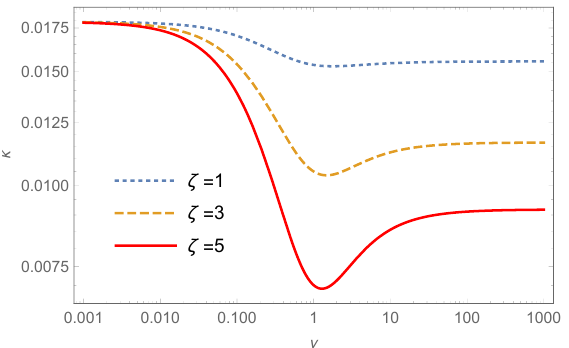
Figure 9 . The dependence of the transition rate of the Hawking-Page phase transition from the large SAdS black hole state to the thermal AdS state on the decay coefficient γ for the oscillatory friction kernel. In the plot, L = 1 , T = 0 . 5 , and ˜ ω = π 3